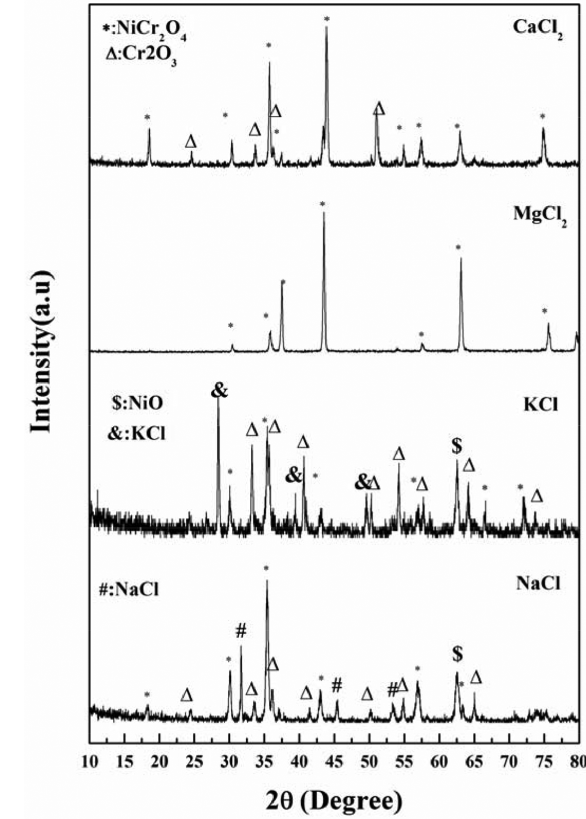
Figure 3: XRD patterns of the corrosion products formed on Inconel 625 in molten chloride salts at 900°C.